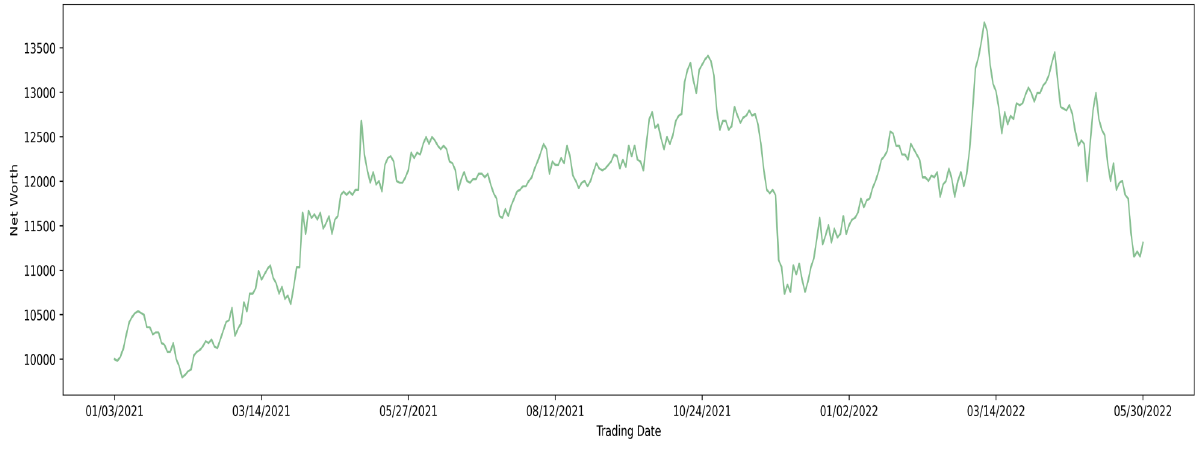
Figure 24. 2010 stock net worth prediction on test data set (initial portfolio value